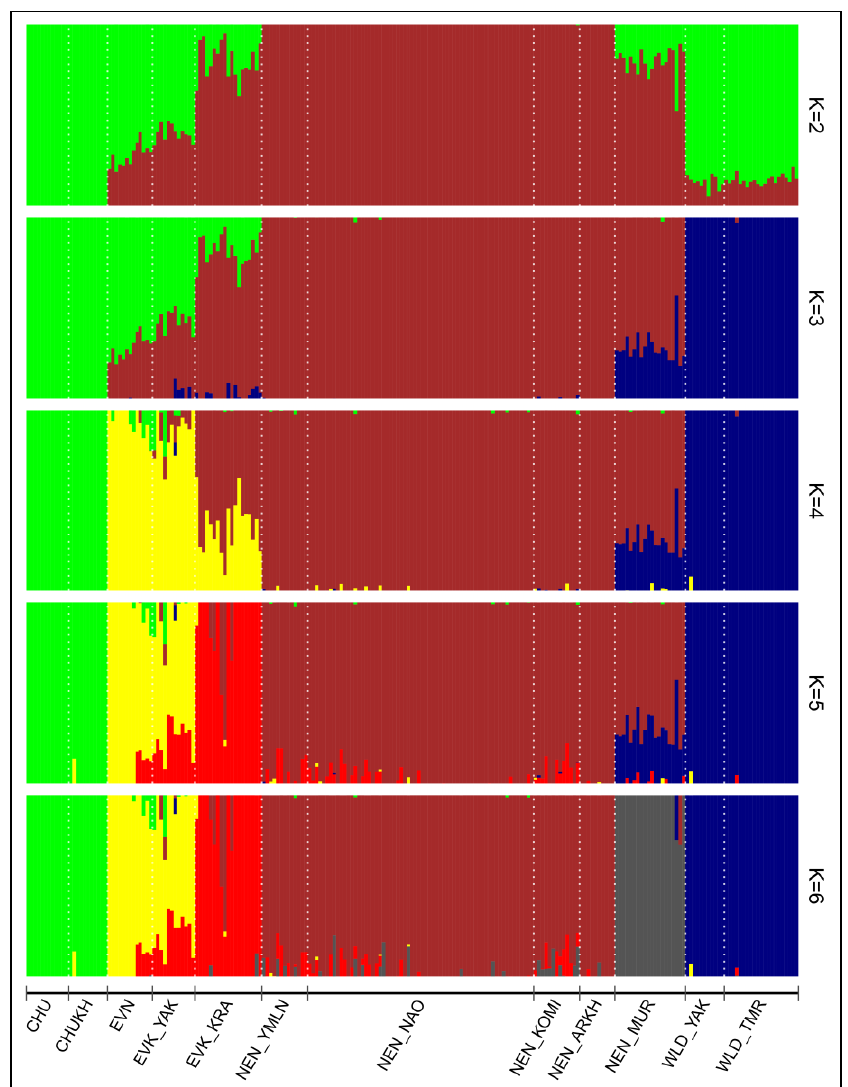
Figure 5. Admixture analysis of the Russian reindeer breeds. CHU, Chukotka; CHUKH, Chukotka– Khargin; EVN, Even; EVK_YAK, Evenk of the Yakutia region; EVK_KRA, Evenk of the Krasnoyarsk region; NEN_YMLN, Nenets of the Yamalo-Nenets Autonomous district; NEN_NAO, Nenets of the Nenets Autonomous district; NEN_KOMI, Nenets of the Komi Republic; NEN_ARKH, Nenets of the Arkhangelsk region; NEN_MUR, Nenets of the Murmansk region; WLD_YAK, wild reindeer of the Northern Yakutia; WLD_TMR, wild reindeer of Western Taymyr.